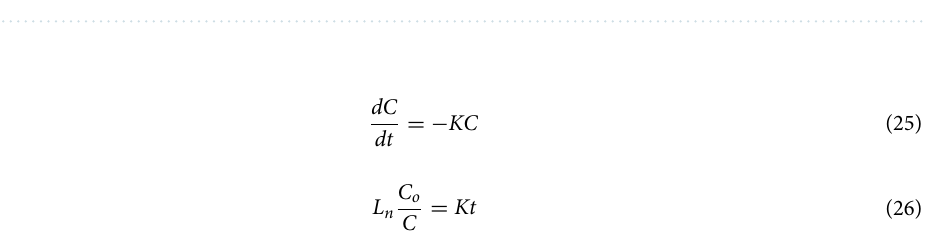
Table 6. R 2 and K values for various kinetic models for CPKC at pH 3 and Temperatures 30 °C, 35 °C and 40